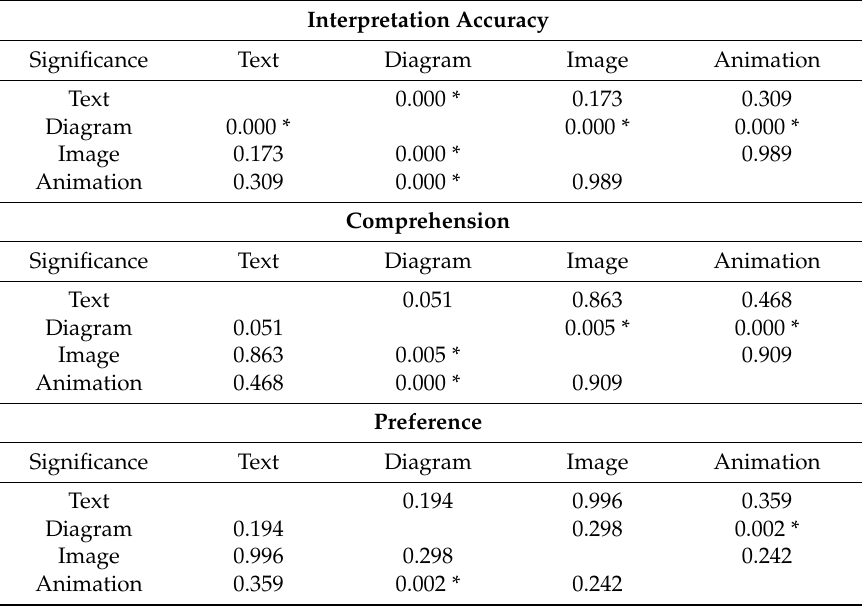
Table 6. Post-hoc test: interpretation accuracy, comprehension, and preference.